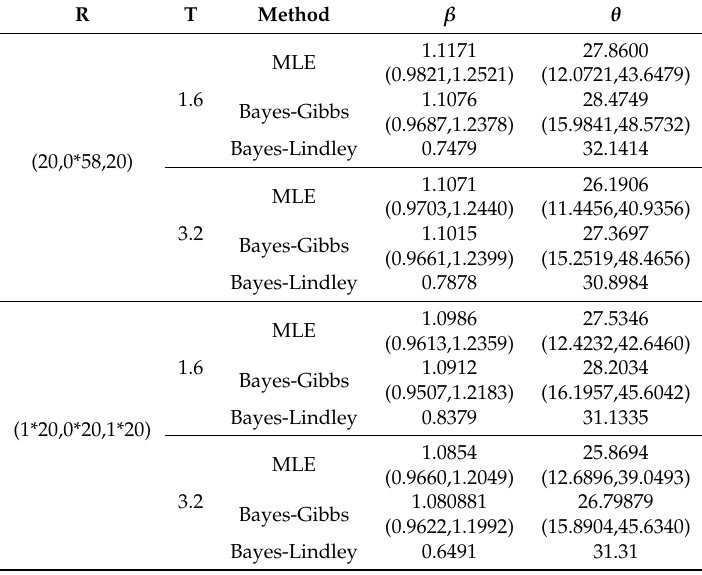
Table 14. Point estimates and 95% intervals of the real data set under different methods. R